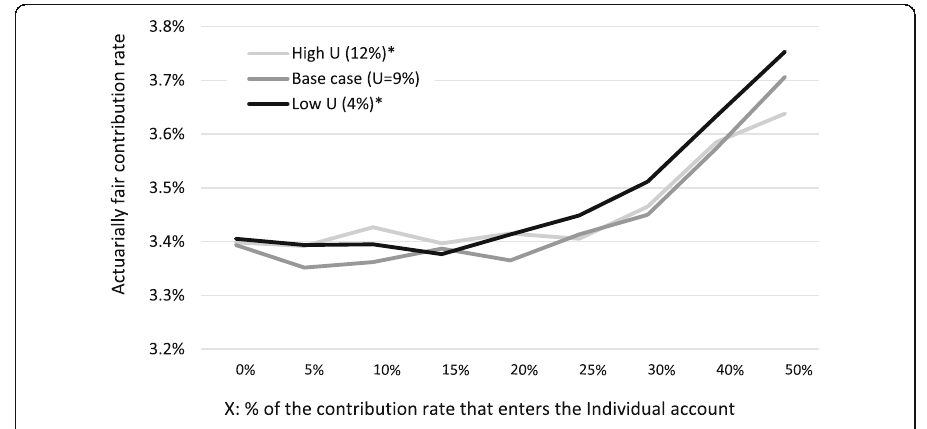
Fig. 3 Simulated actuarially fair contribution rate by X and unemployment level. Source: author ’ s calculation, using a simulated population. The asterisk indicates the replacement rate is set at 50% in the base case and is set at a higher/lower value in the lower/higher unemployment scenario to facilitate the graphical comparison (by keeping the risk-pooling actuarially fair contribution at 3.4). The unemployment level refers to the one before introducing the individual accounts. The pure risk-pooling average duration of unemployment/employment is set to 6/60 months. F , the percentage increase in the job finding rate during the self-financeable stage of the unemployment spell, is set at